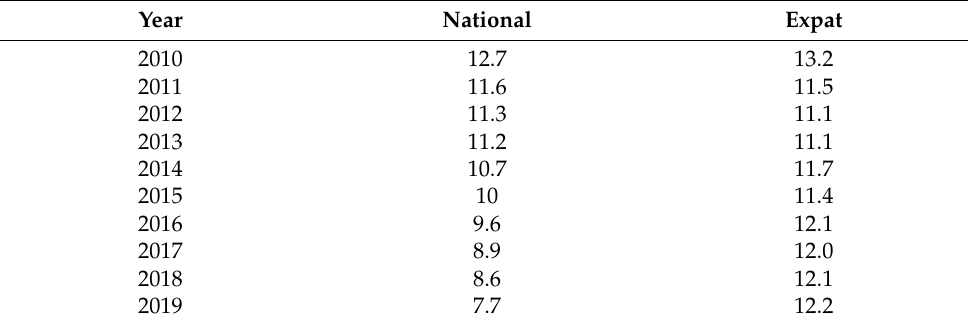
Table 2. Persons per connection for national and expat populations.